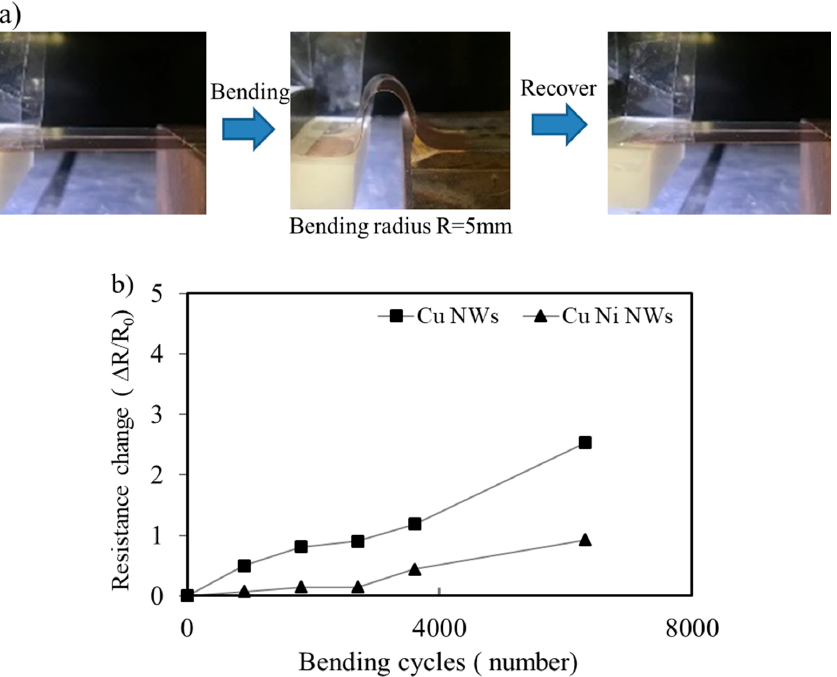
Figure 10. ( a ) The images of the bending and recovery process with a bending radius, R = 5 mm and ( b ) the chart of the number of repeating bending cycles with the change in resistance ( Δ R/R 0 ).